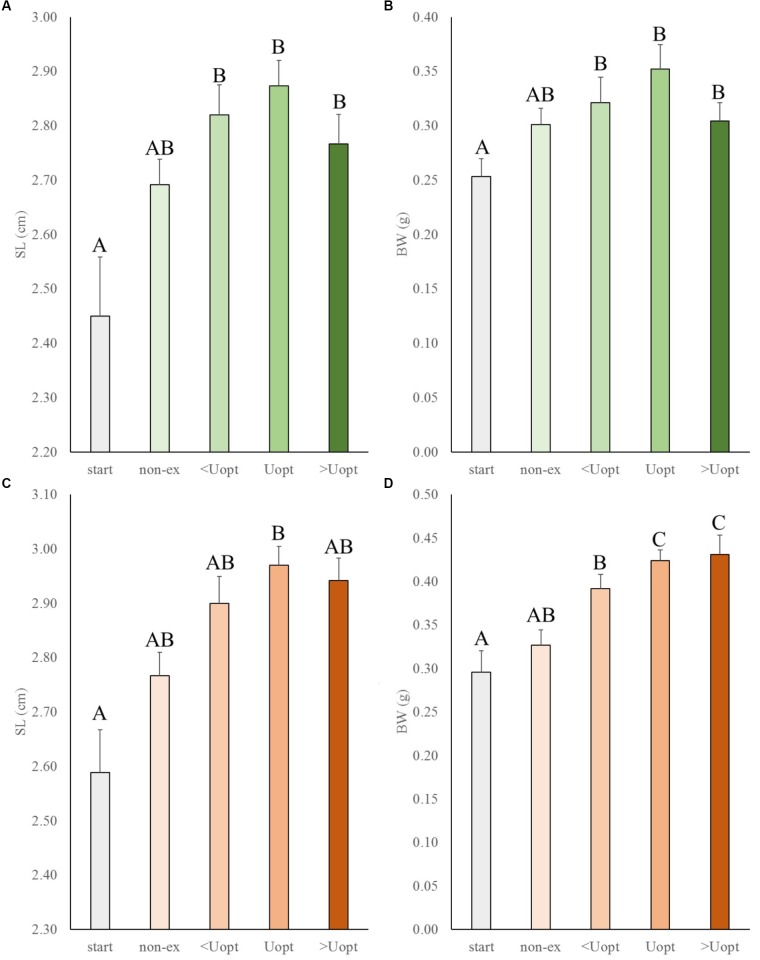
Experiment II: Exercise effects on size in wild-type and Gr mutant zebrafish. (A) Standard length (SL) and (B) body weight (BW) in wild-type zebrafish (green), and (C) SL and (D) BW of Gr mutant zebrafish (orange), at the start of the experiment (start), after 4 weeks without (non-ex) and with subjection to the daily exercise protocol swimming at the suboptimal (<Uopt), optimal, and super optimal (>Uopt) swimming speeds of 0.3, 0.4, and 0.5 m s-1, respectively. Differences in letters mark significant differences (P < 0.05).